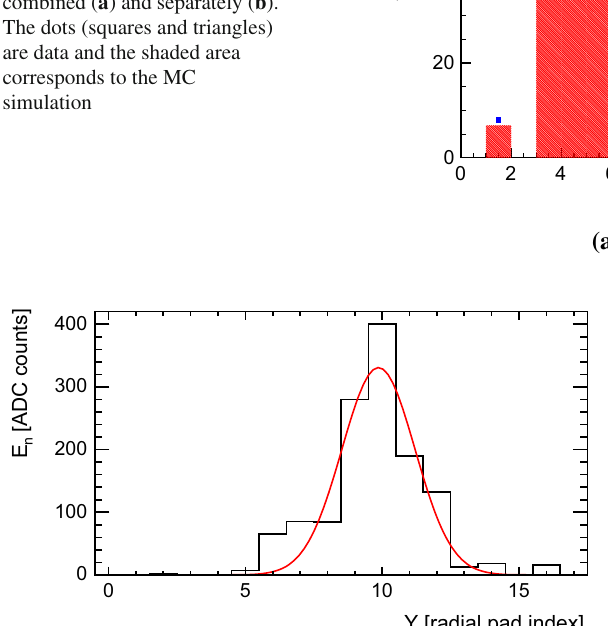
Fig. 19 Average energy deposited in the detector planes of the LumiCal detector prototype as a function of the number of tungsten absorber layers for three configurations combined ( a ) and separately ( b ). The dots (squares and triangles) are data and the shaded area corresponds to the MC simulation